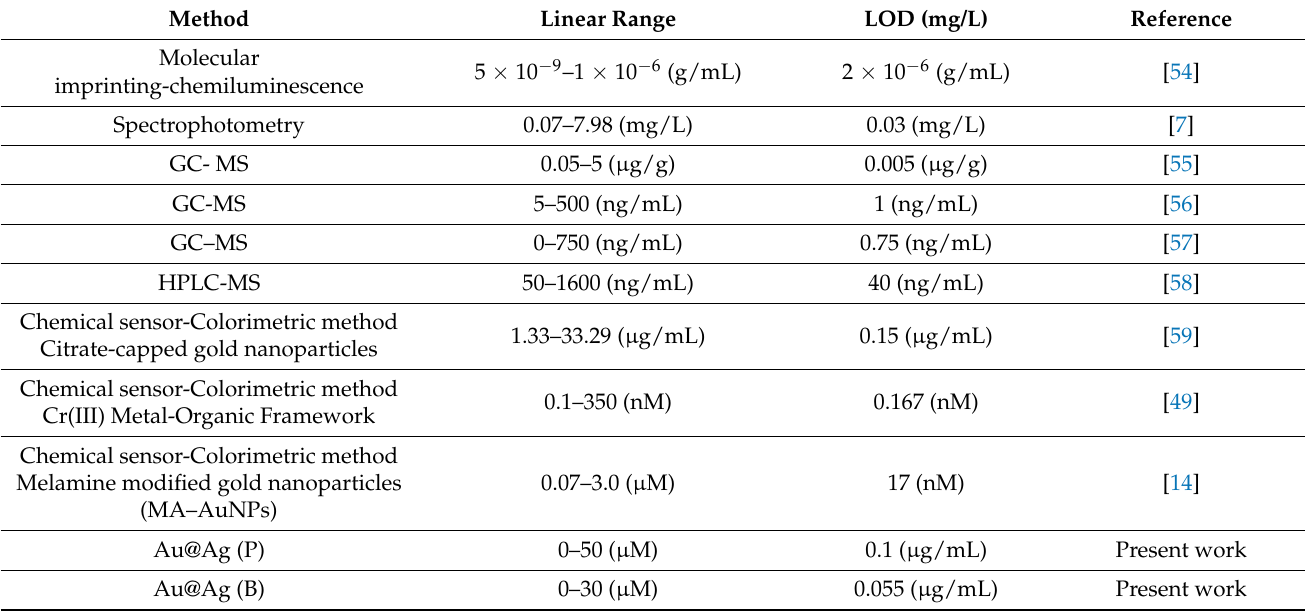
Table 3. Comparison of detection method for